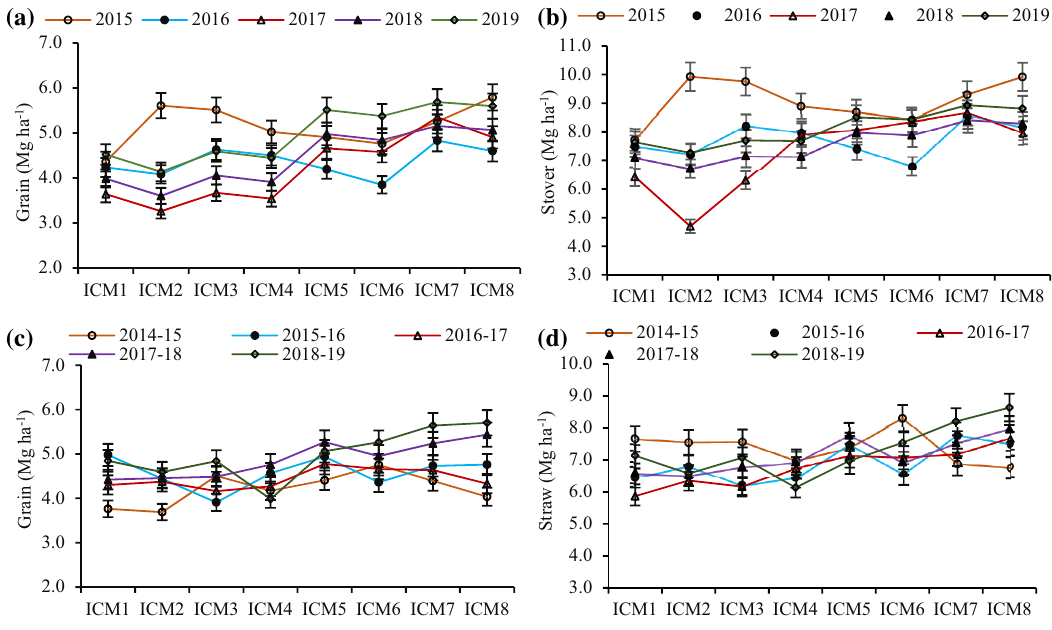
Figure 1. Five years’ maize grain and stover ( a , b ); wheat grain and straw ( c , d ) yield trend under different ICM modules in maize-wheat rotation. The vertical bars indicate LSD at p = 0.05.